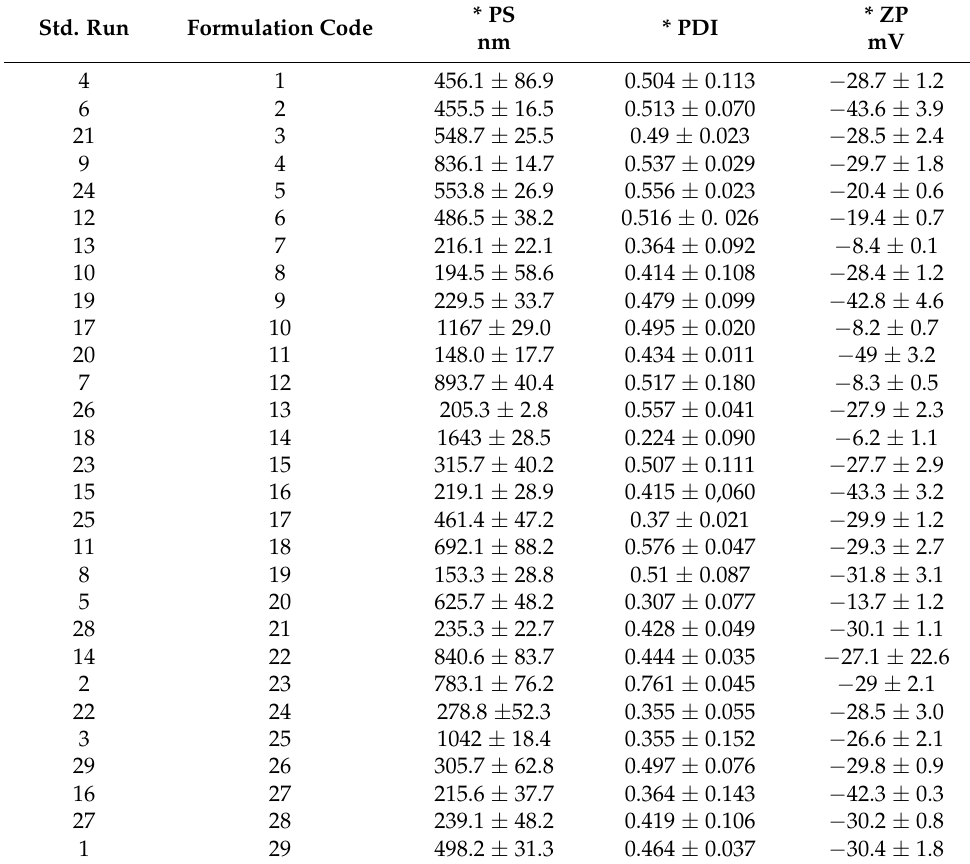
Figure 2. 3D response surface plot depicting the impact of milling time and number of milling balls on particle size of a nano co-crystal (NCC). Table 3. Results observed following BBD